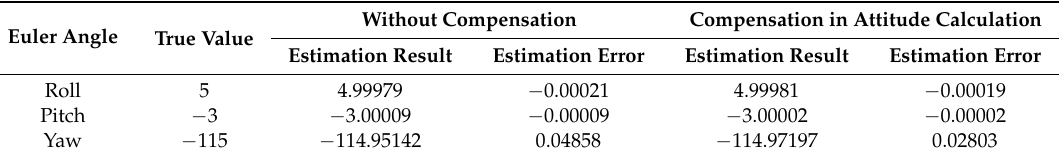
Table 5. When n (cid:48) frame is the navigation coordinate frame, estimation accuracy comparison of the simulations, unit: degree.